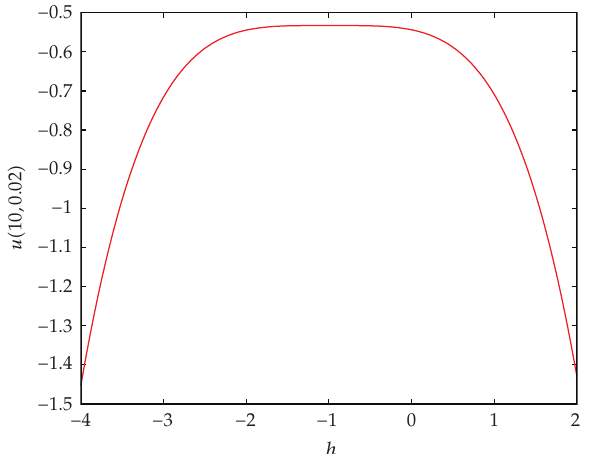
Figure 4: The h -curves obtained from the 5-order HAM approximate solution.